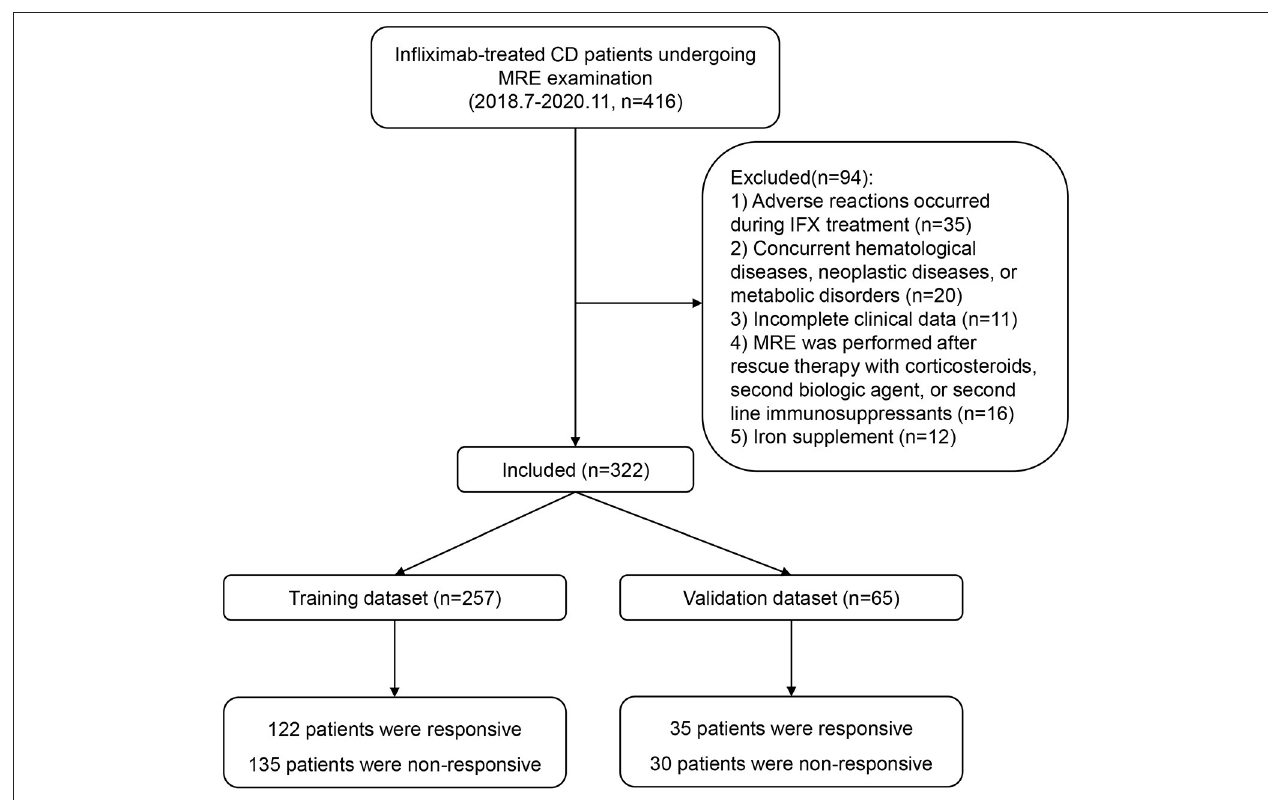
FIGURE 1 | Recruitment process for patients in the training set and validation